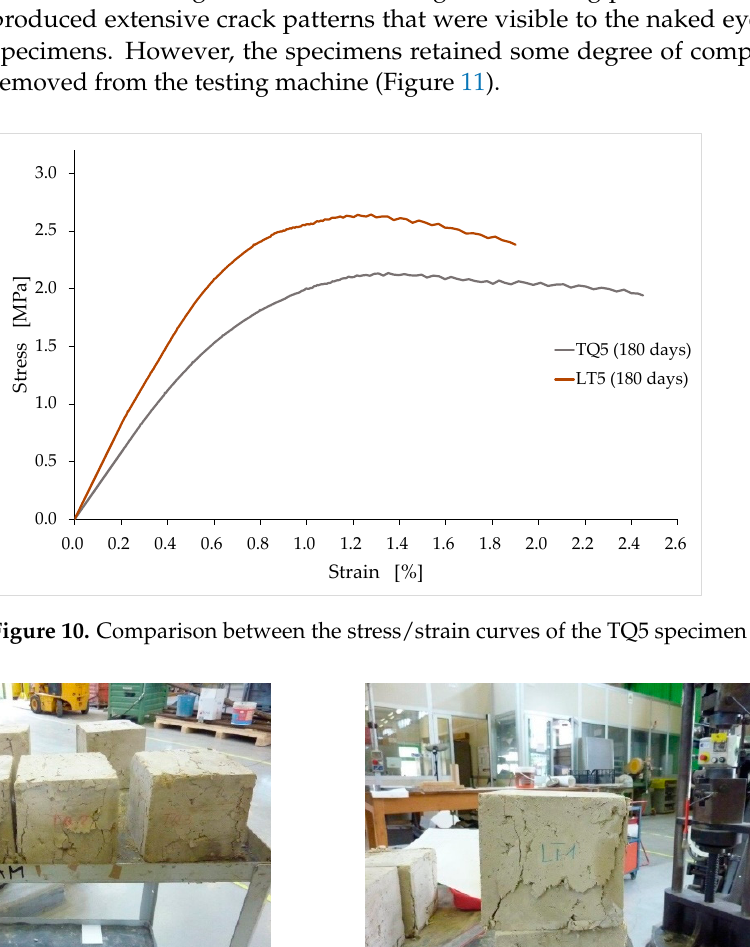
Figure 12. Minimum, average, and maximum values of compressive strength after 90 days of curing.